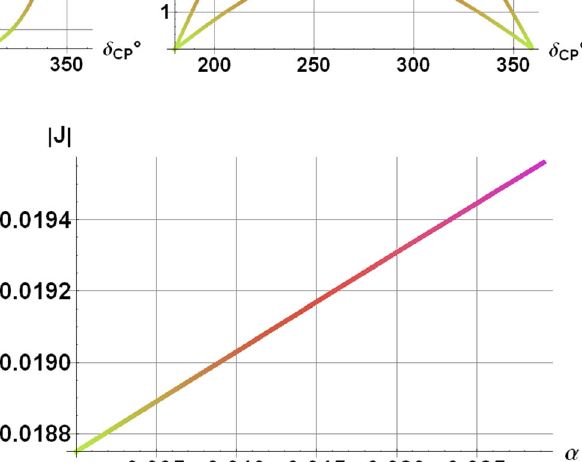
Fig. 8 Dependence δ 1 (δ CP ) – left plot; δ 2 (δ CP ) – right plot, upper line, δ 3 (δ CP ) – right plot, lower line